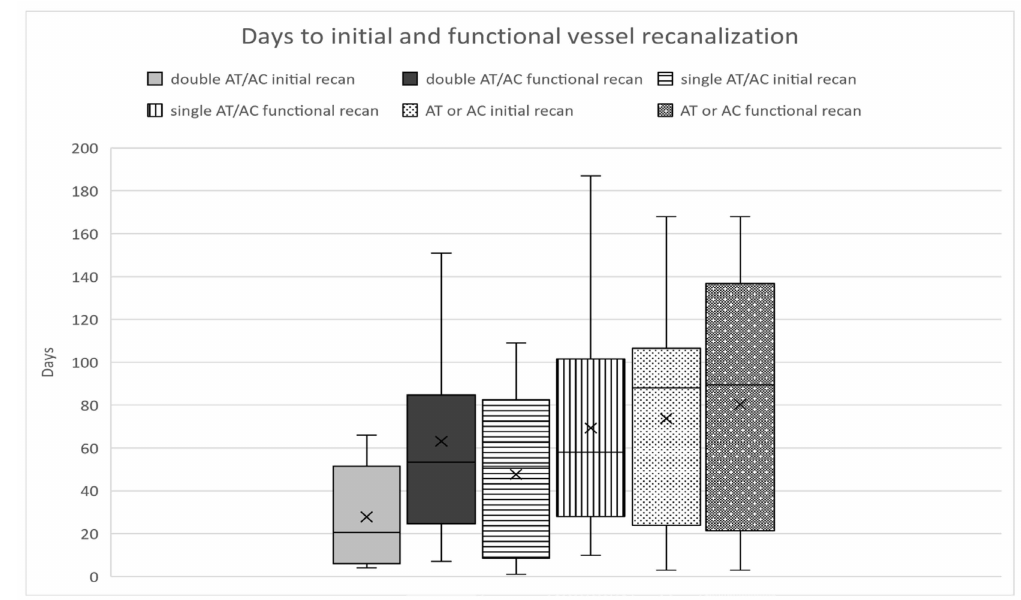
Figure 2. Days to the initial and functional vessel recanalization after cervical artery dissection in the different treatment